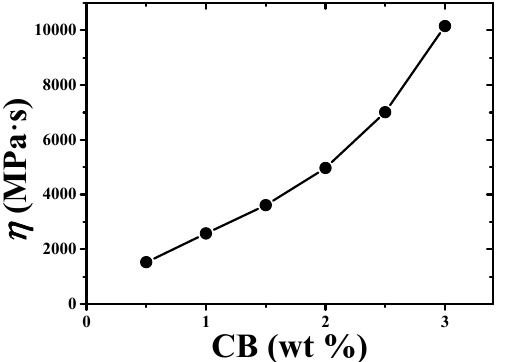
Figure 5. The viscosity of the precursor solution of the ternary conductive nanocomposite as a function of the CB content.